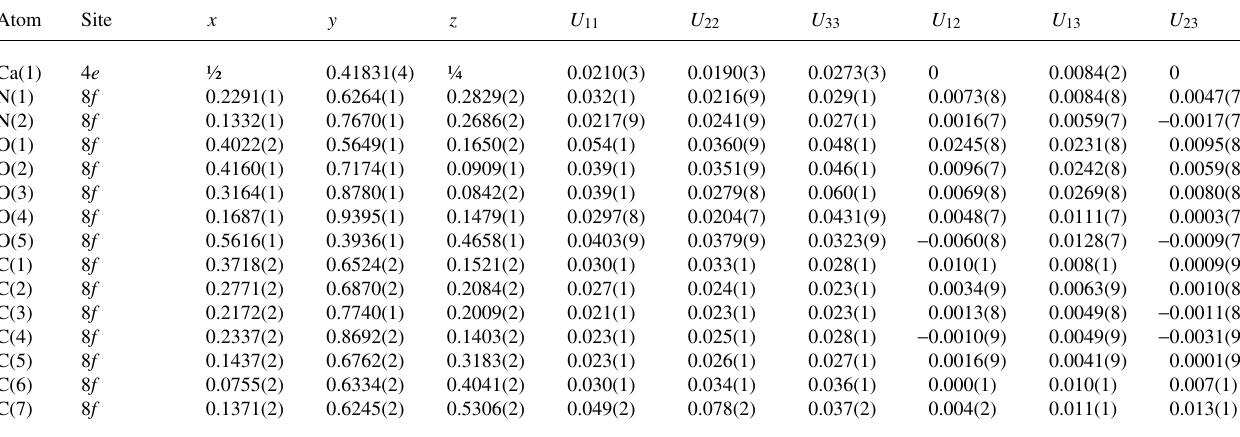
Table 3. Atomic coordinates and displacement parameters (in Å 2 )